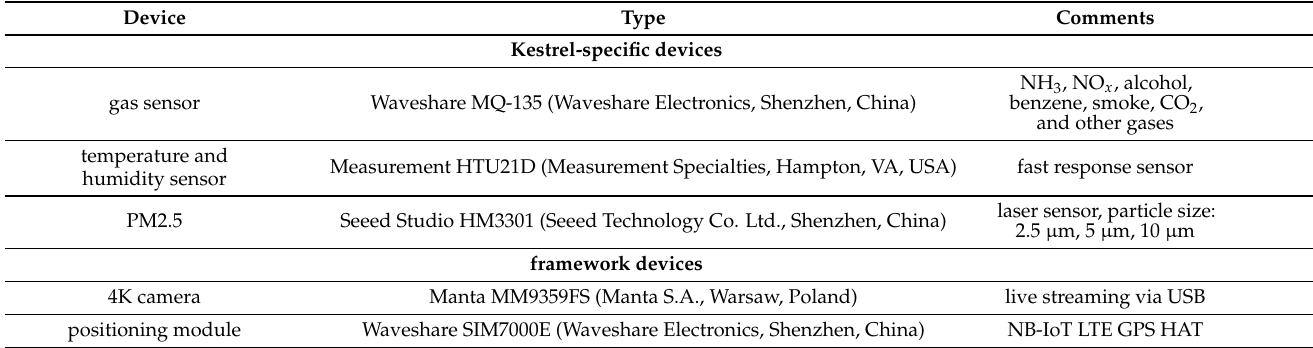
Table 1. Input devices used in the air station of the Kestrel